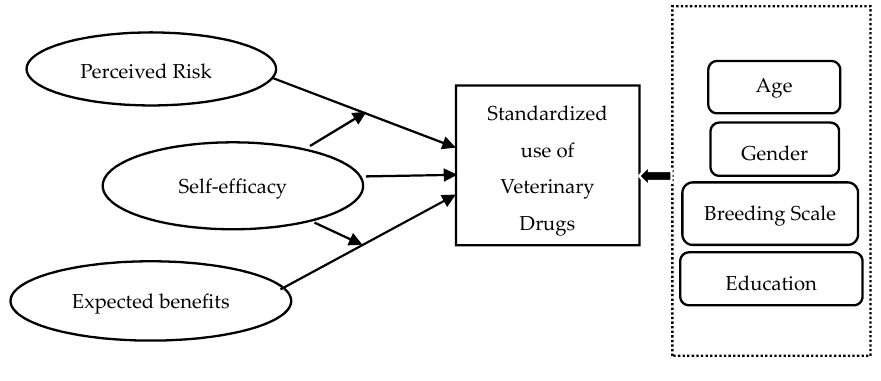
Figure 1. Conceptual framework.